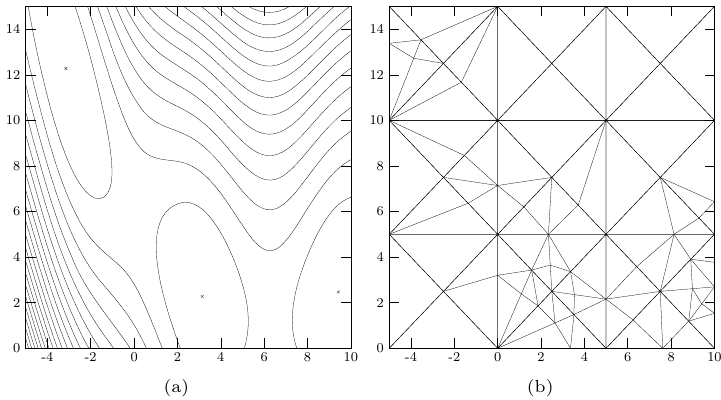
Figure 3. The Branin function presented by contour lines and the simplicial covering of the feasible region after termination with Δ = 0 . 1 d